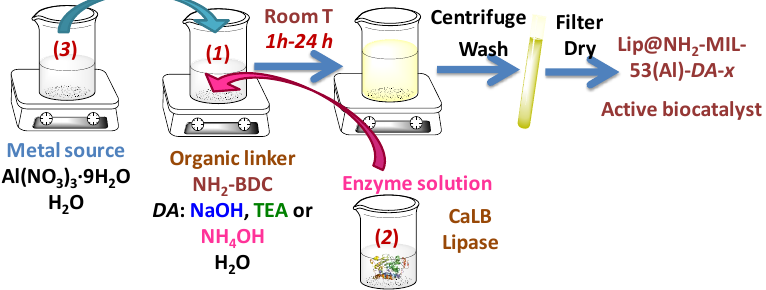
Scheme 1. Procedure for the preparation of Lip@NH 2 -MIL-53(Al)-DA- x biocatalysts by the in